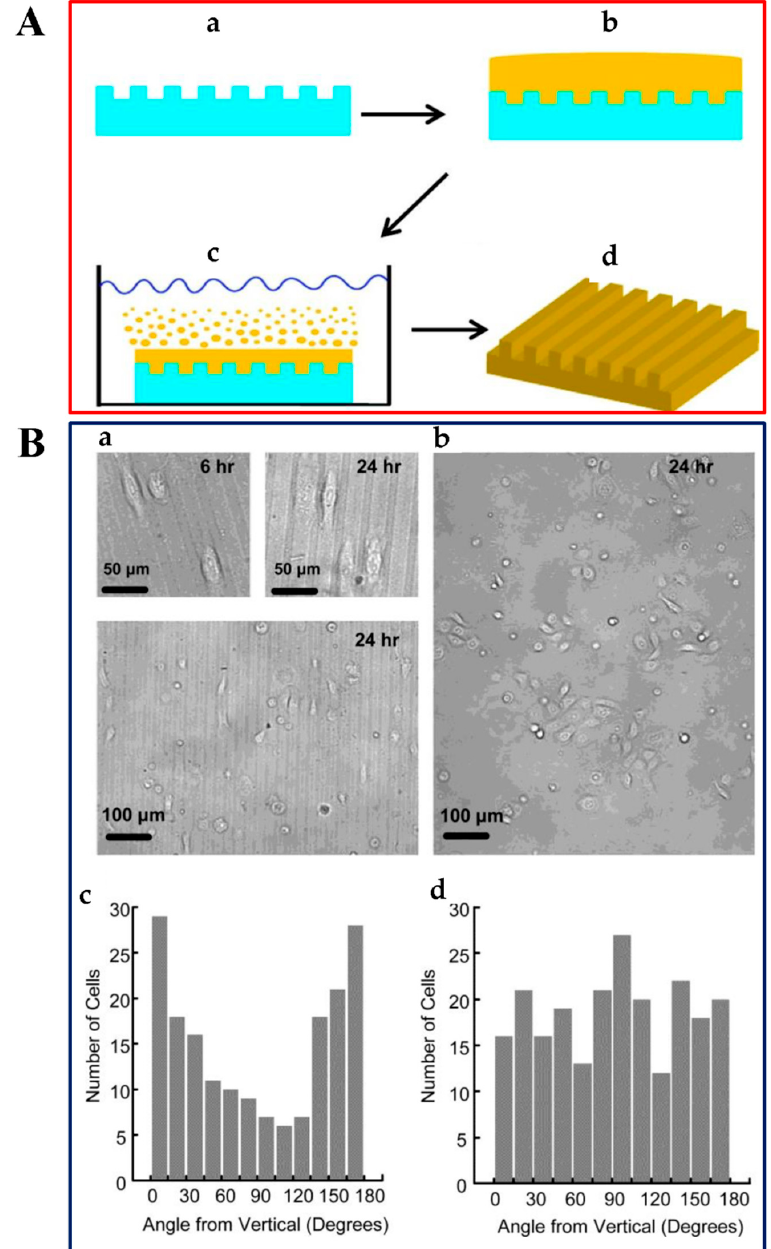
Figure 7. ( A ) Schematic illustration of the production of patterned SF films: ( a ) Pre-designed polydimethylsiloxane (PDMS) stamp; ( b ) Spin-coating SF solution on the PDMS; ( c ) Extracting the ionic liquid solvent in a methanol bath; ( d ) Peeling the crystallized patterned SF film from the stamp; ( B ) Data of cell alignment on patterned SF films as compared to the unpatterned (collagen-coated) films: Optical micrographs of keratinocytes growing on ( a ) patterned SF films at 6 and 24 h and ( b ) unpatterned film at 24 h; Histograms of cell alignment on ( c ) patterned SF films and ( d ) unpatterned films. The x -axis represents cell angle; the y -axis represents cell counts. Adapted with permission from [101]. Copyright (2007) American Chemical Society.